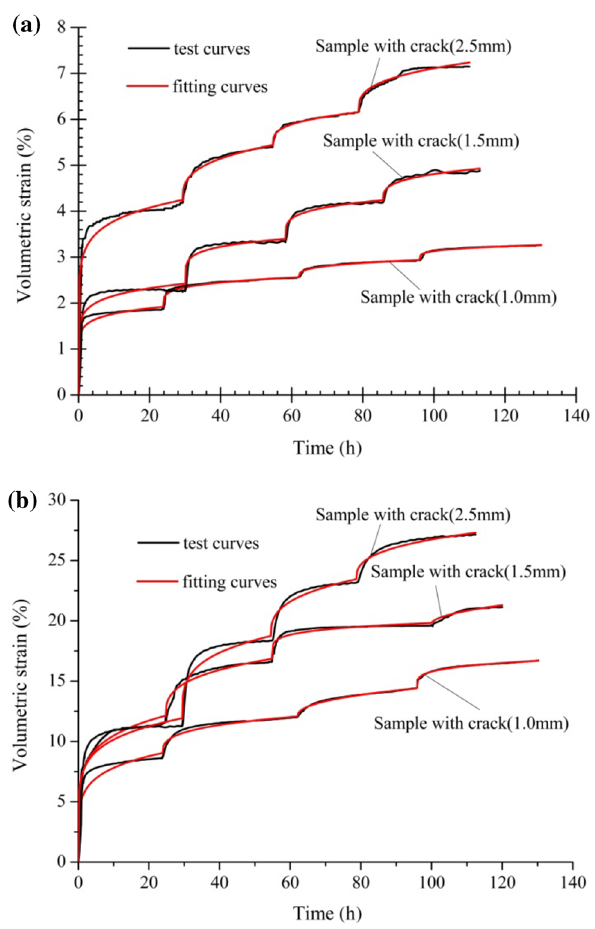
Fig. 10 Creep test results and fitting curves of model: a Jingle laterite specimens, b Baode laterite specimens